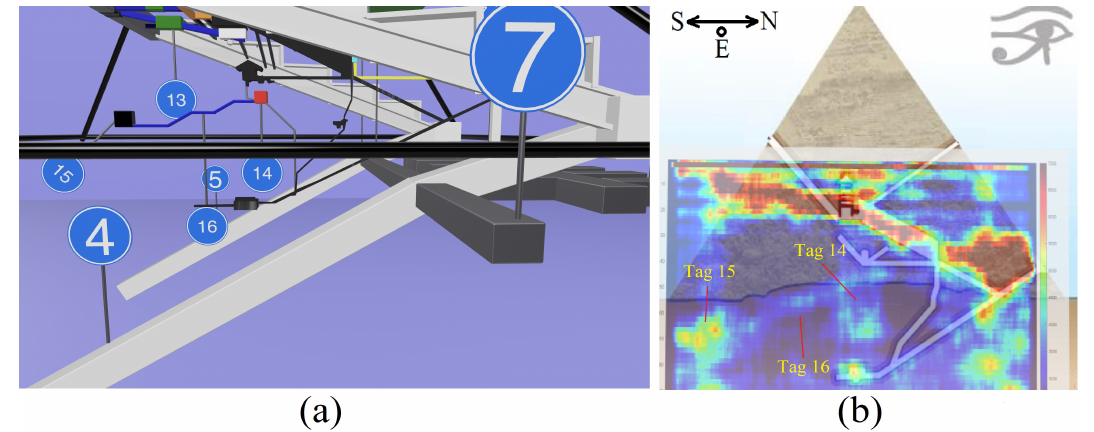
Figure 52. Tags association from tomography to 3D model. ( a ): Three-dimensional (3D) model of Khnum-Khufu. ( b ): Tomographic reconstruction